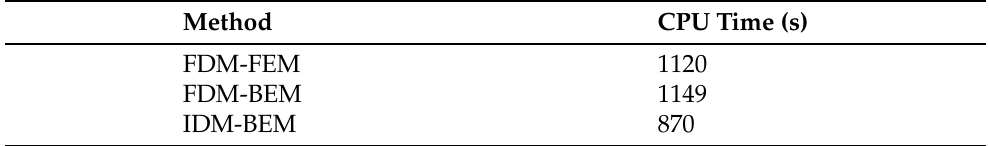
Table 3. CPU time to calculate 100 sensitivities using each of the three methods.